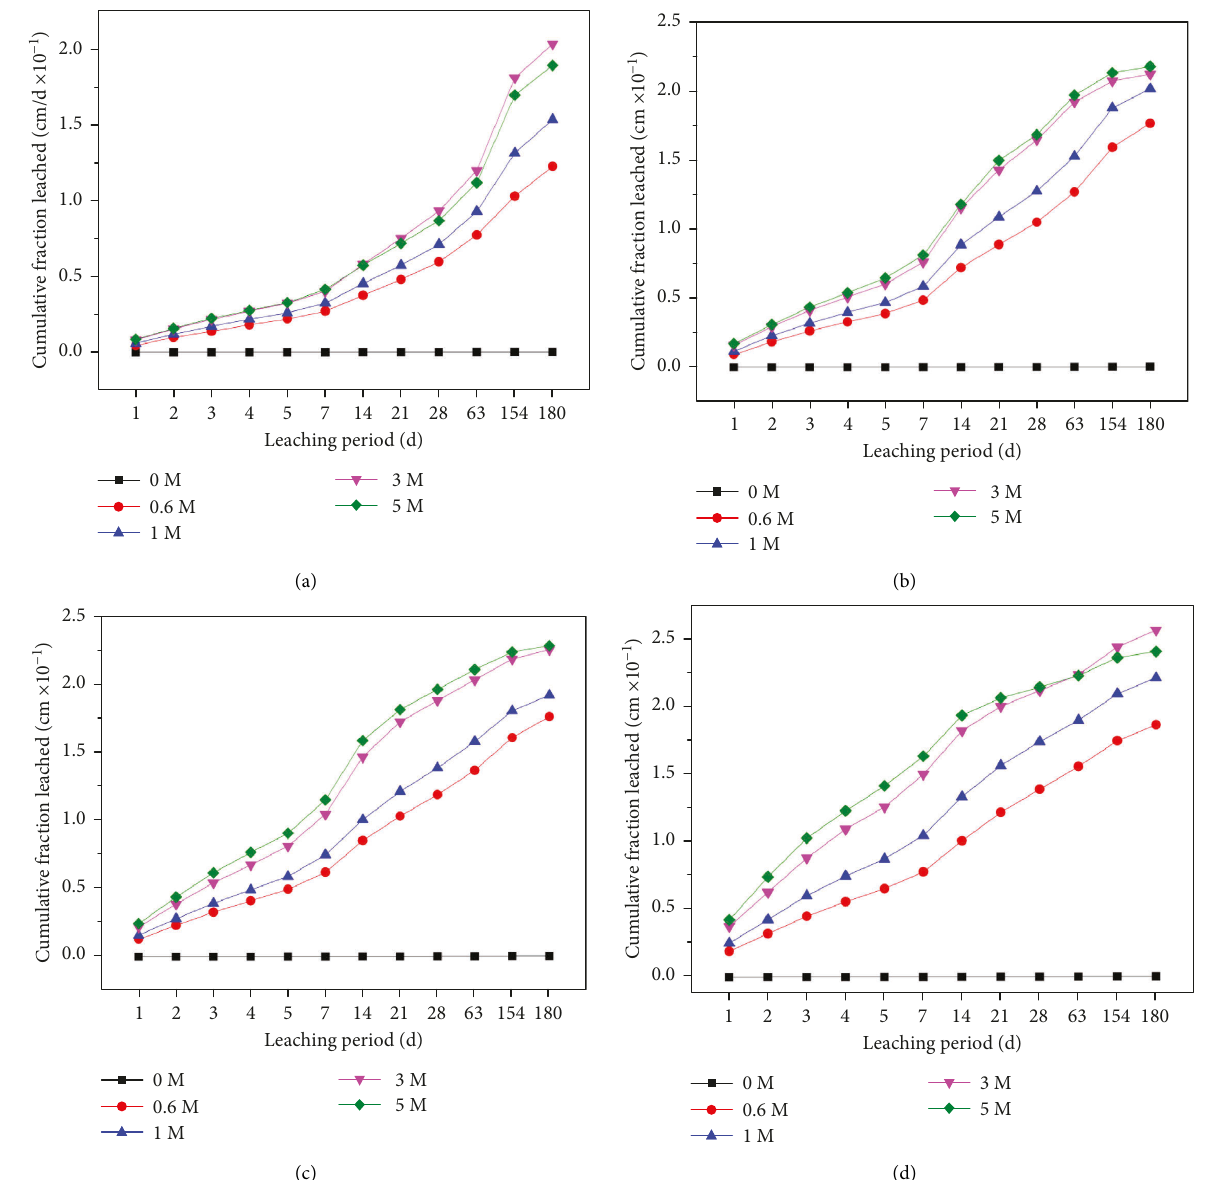
Figure 7: CFL of Sr 2+ in fly ash/cement waste forms under simultaneous effect: (a) 20 ° C; (b) 40 ° C; (c) 60 ° C; (d) 80 °